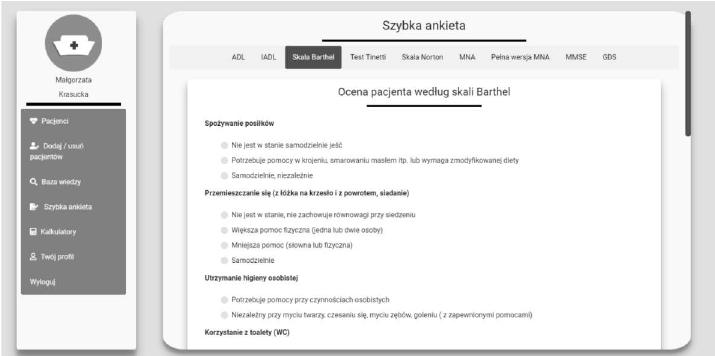
Figure 9. Appearance of the quick health assessment module based on the CGA tool – part 1